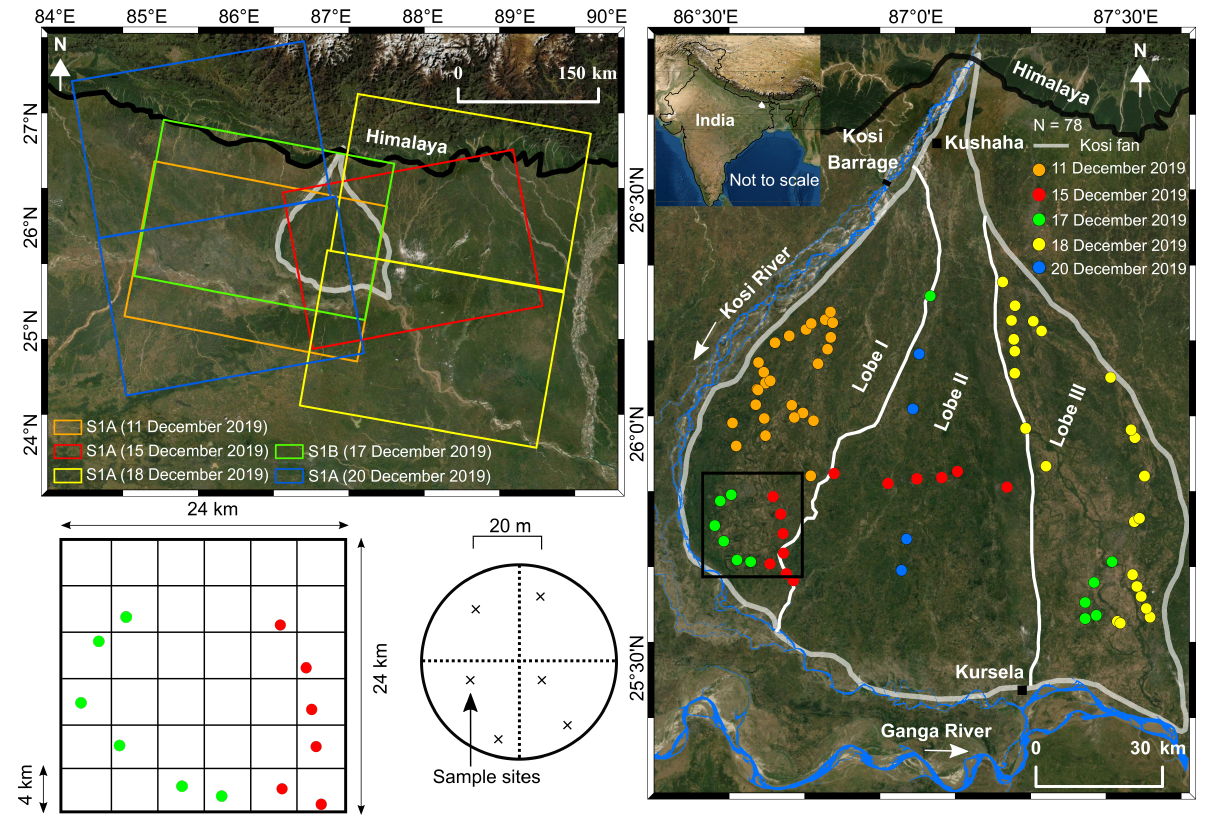
Figure 1. Image in the top left shows the location of the Kosi megafan in the Himalayan Foreland, India. The rectangles in different colours represent the Sentinel-1 footprints on different dates during the field campaign. Image in the right shows the Kosi Fan boundary and locations of in-situ measurements in the field. Circles in different colours show the measurements locations on different dates. Grids in the bottom left illustrate the random sampling strategy for the measurements.